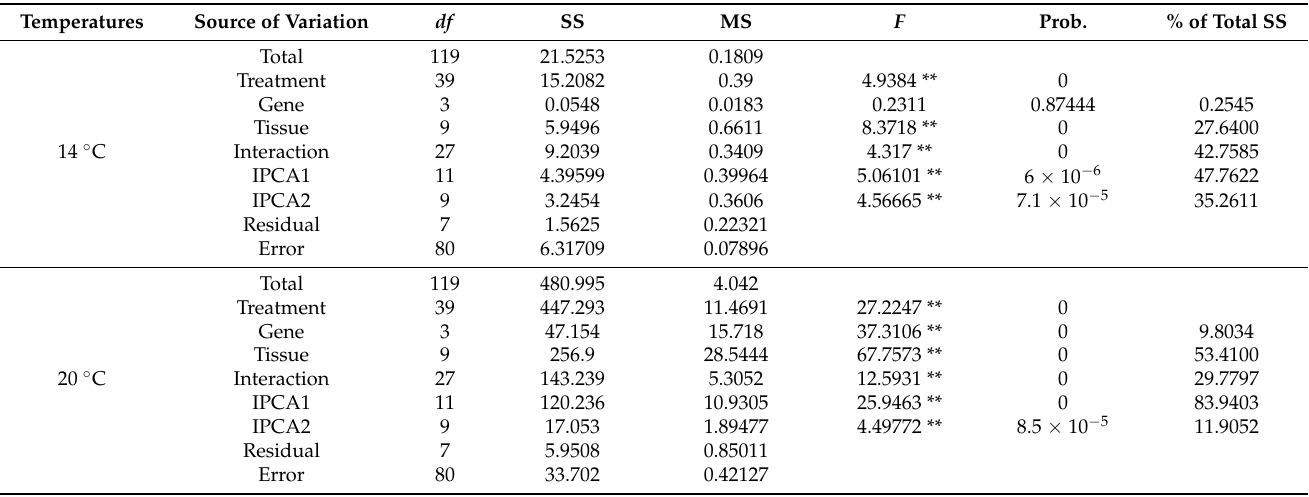
Table 2. AMMI analysis results for PPAR α 1 , PPAR α 2 , PPAR β , and PPAR γ in different tissues at different